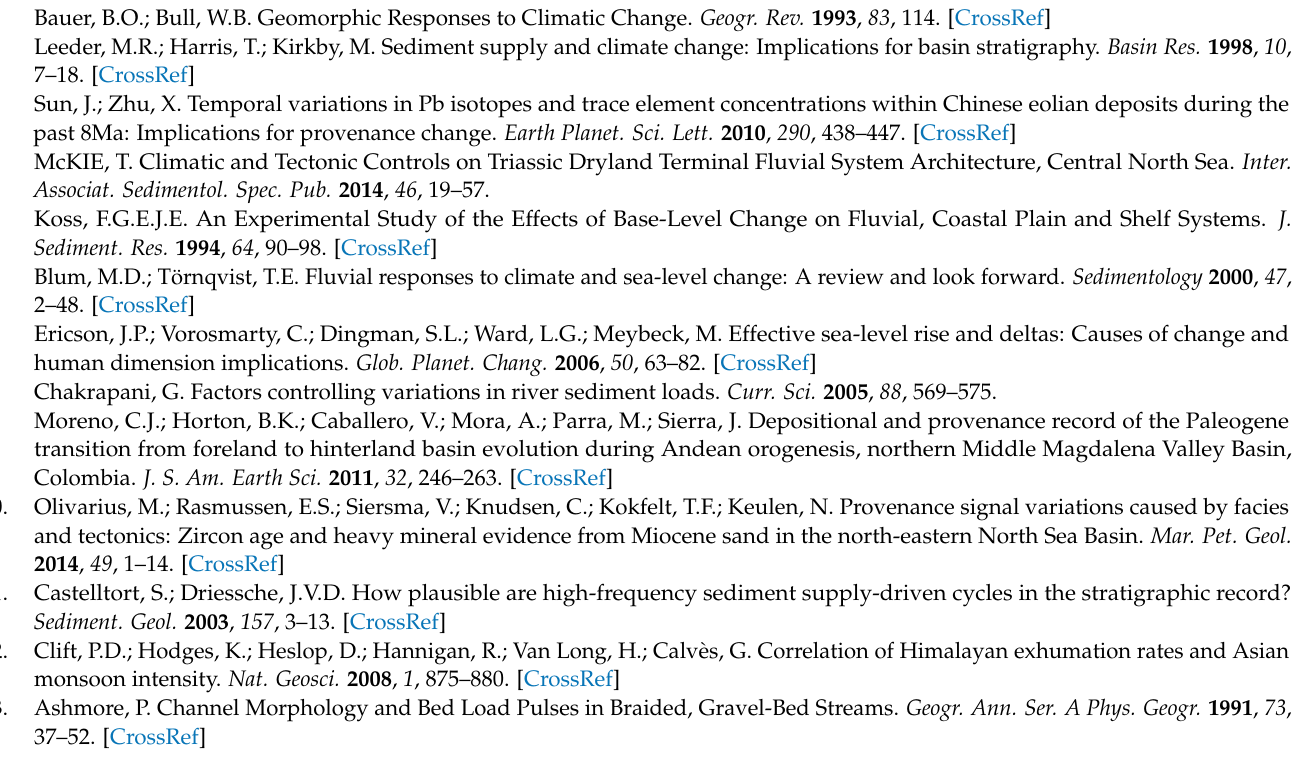
Table S4: Apatite trace elements; Table S5: Trace elements in apatite SVM prediction with age; Table S6: Petrographic